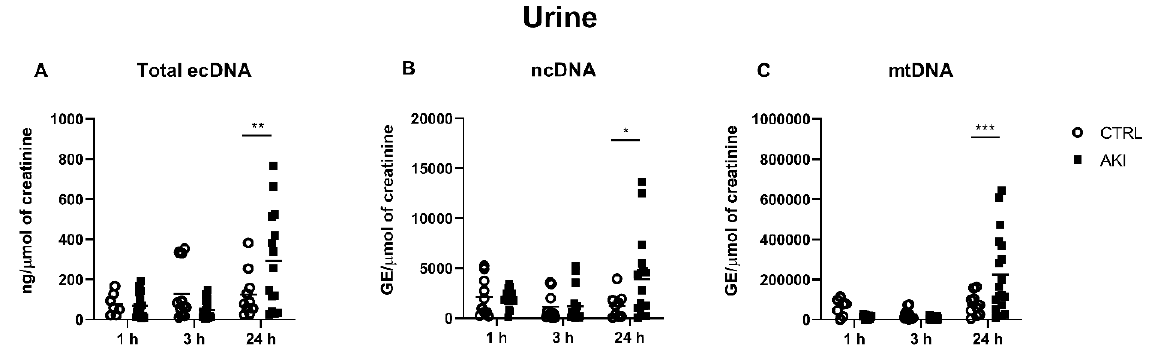
Figure 3. Concentrations of urinary total ecDNA ( A ), ncDNA ( B ) and mtDNA ( C ) per micromole of urinary creatinine at different time points after AKI induction. * denotes p ˂ 0.05. ** denotes p ˂ 0.01. *** denotes p ˂ 0.001. CTRL—control group; AKI—glycerol-induced acute kidney